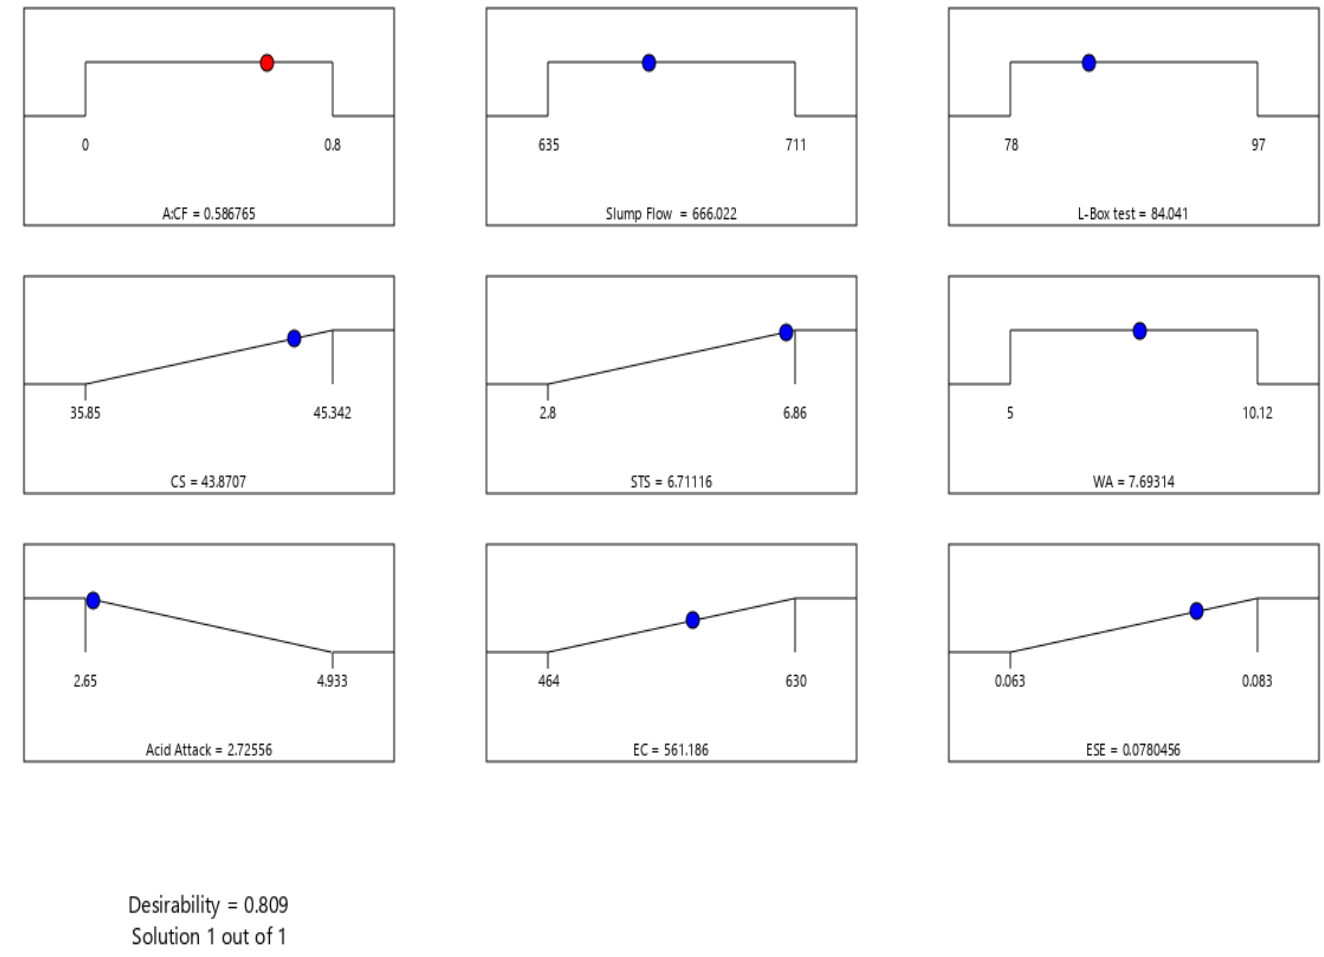
Figure 22. Multiobjective optimization ramp diagram.